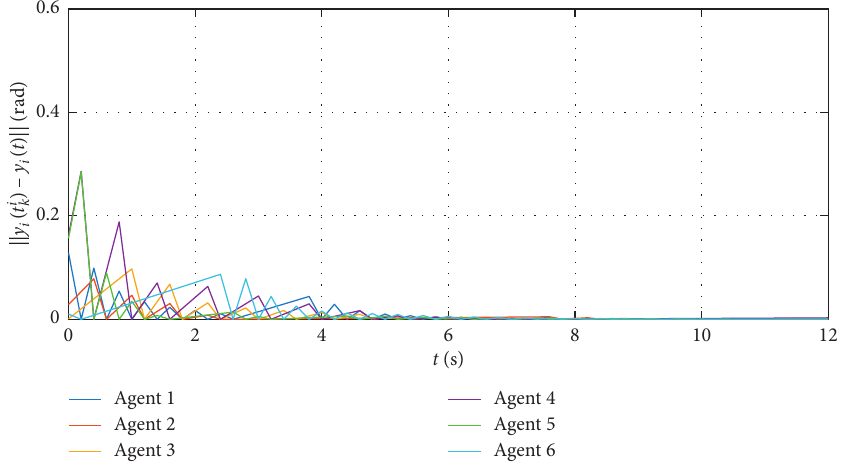
Figure 3: The evolution of ‖ y